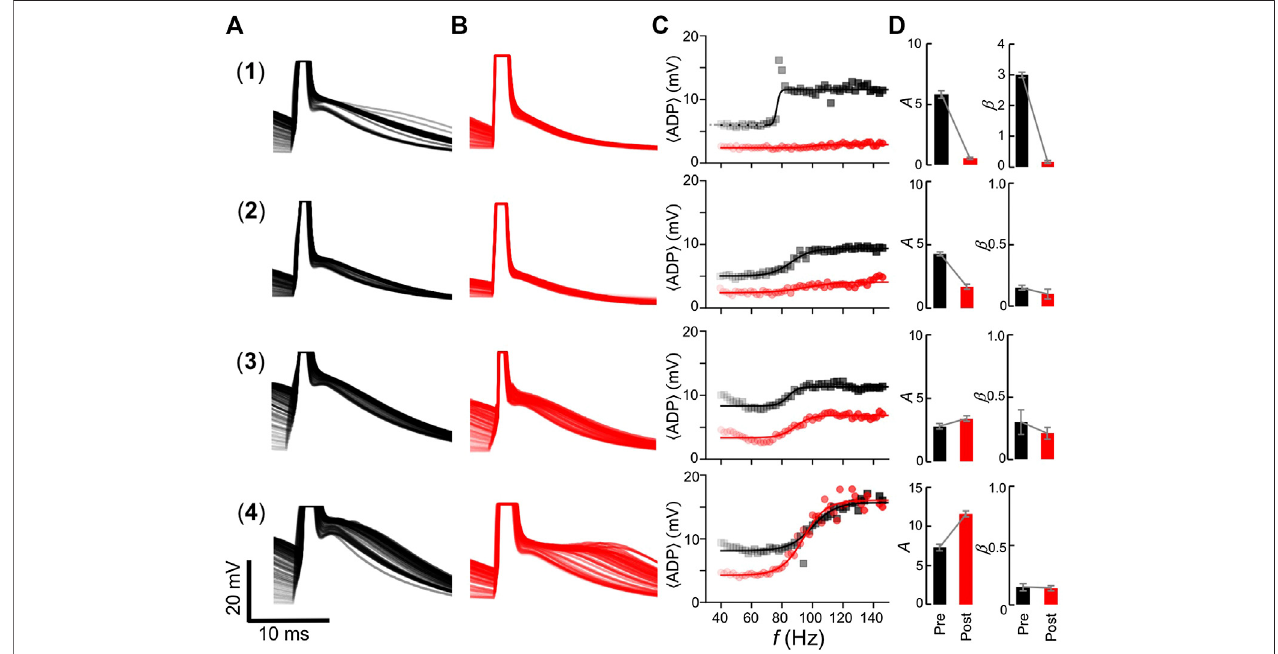
FIGURE6| ADPpro fi leandfrequencyresponsesbeforeandafterdendrotomy.RecordingsfromfourL5PNs(rows 1 – 4 )showing:thesomaticmembranepotential traces before (column A) and after (column B ) dendrotomy aligned to the last AP; (column C ) the corresponding frequency response of the ADP ; and (column D ) the changes in the fi tting parameters of the Sigmoid function, amplitude ( A ) and slope ( β ), before (pre) and after (post) dendrotomy. The error bars show uncertainty of the Sigmoid fi t.